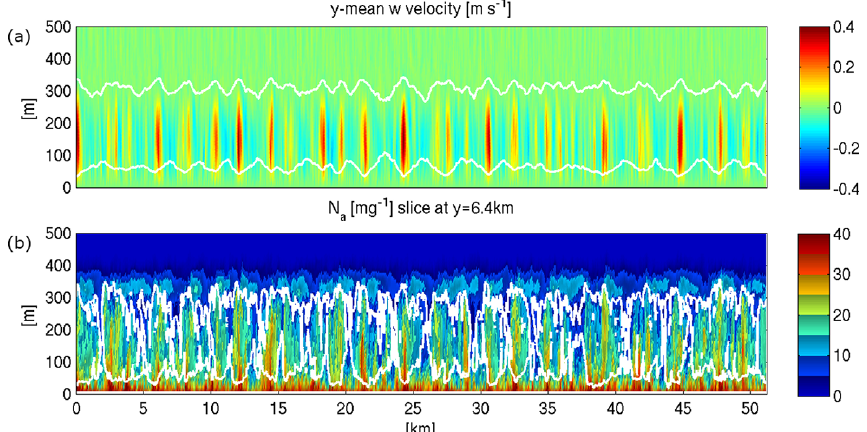
Figure 5. x – z snapshots of (a) y -averaged vertical velocity w and (b) vertical slice of total aerosol number concentration N a at y = 6.4km for run BaseTrack at hour 8. White contours mark the 0.01gkg − 1 cloud water mixing ratio boundary. Differences in contour appearance result from y -average applied to the fields in (a)